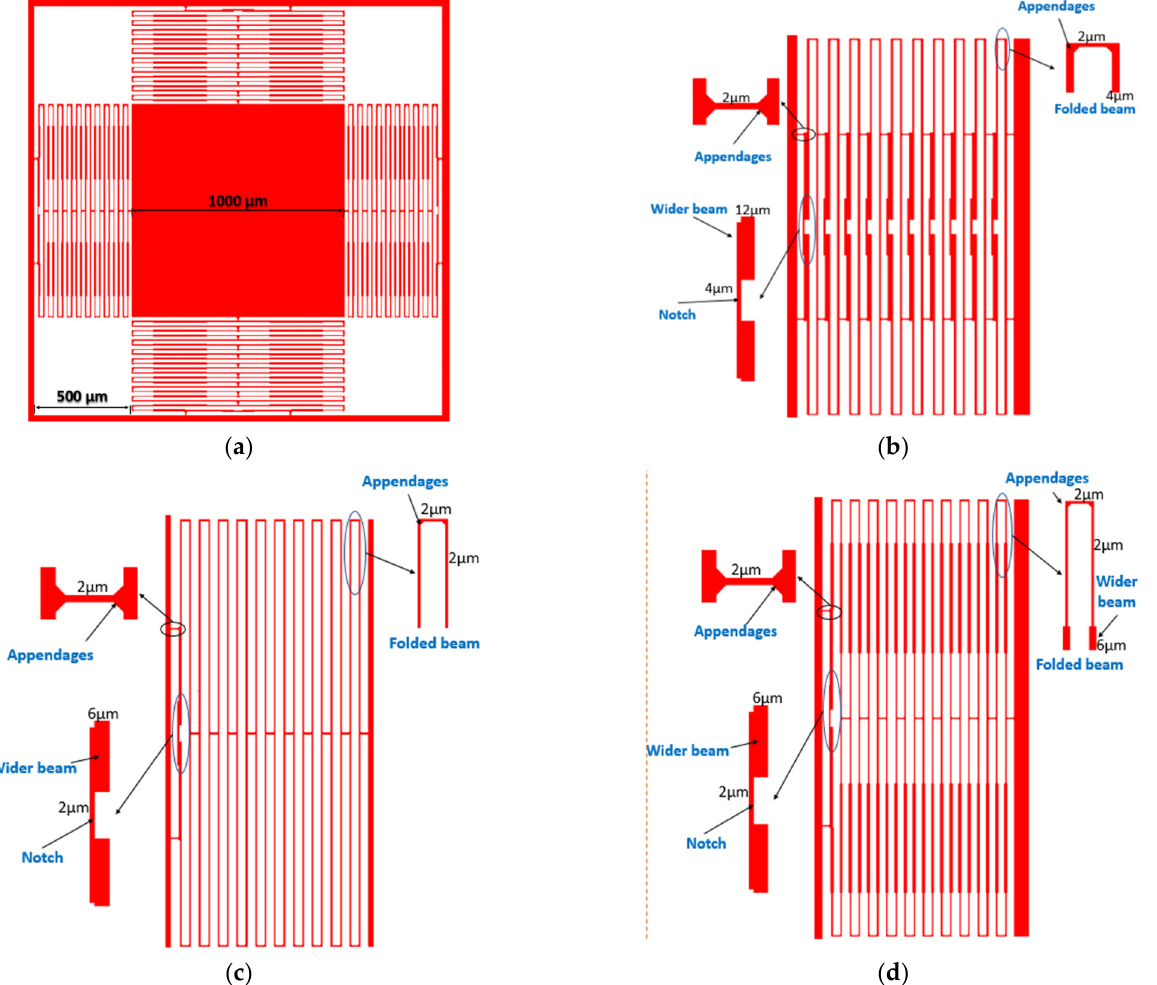
Figure 2. ( a ) Proof mass springs system. ( b ) Design 1: The most robust but least sensitive. ( c ) Design 2: The most sensitive but the most brittle. ( d ) Design 3: A compromise between sensitivity and robustness.